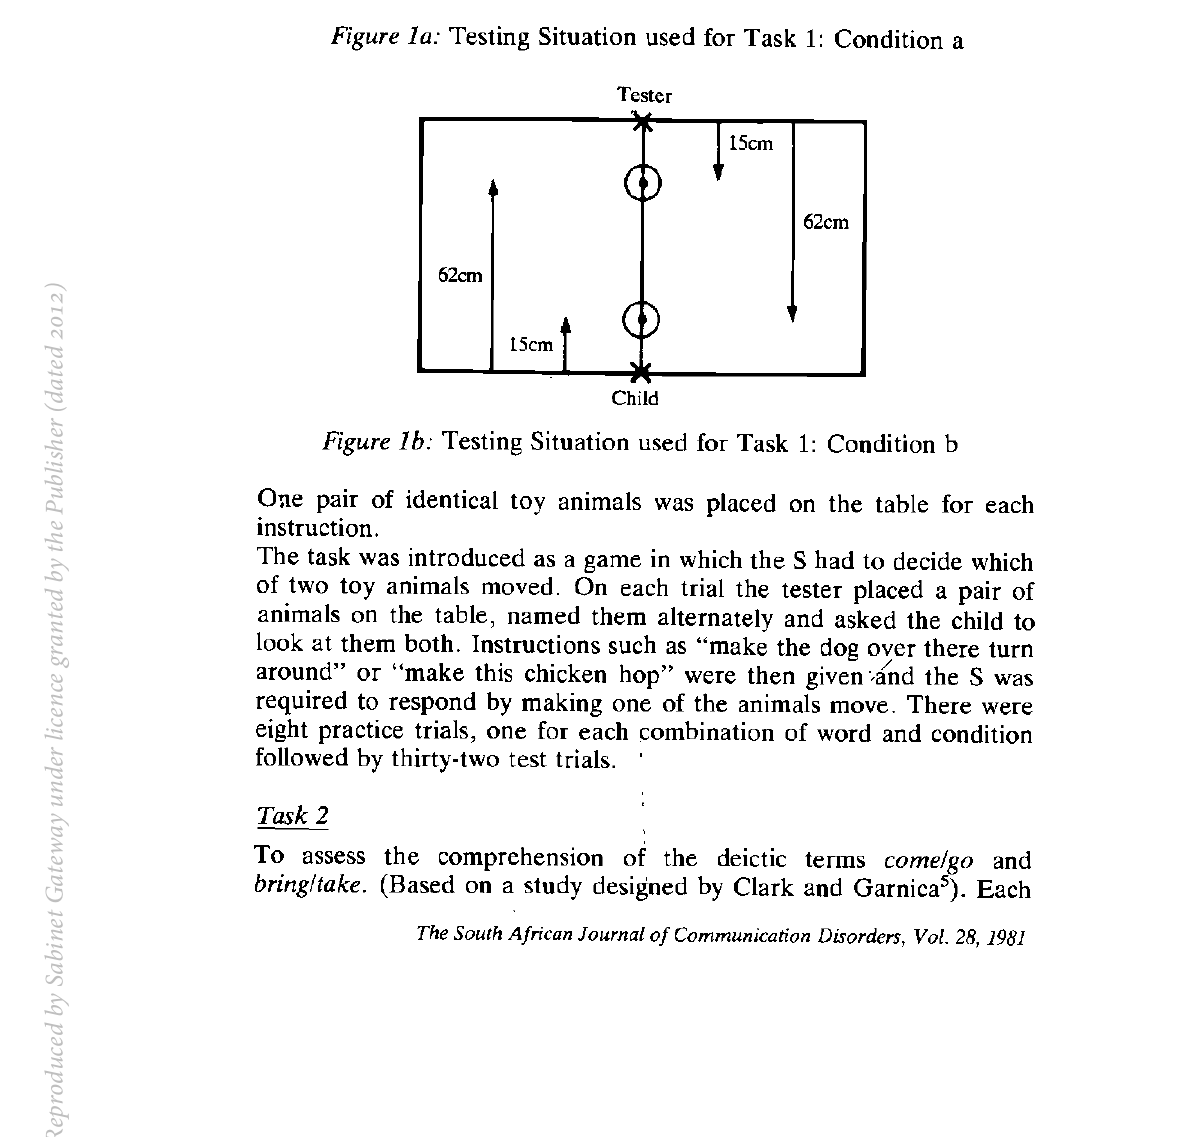
Figure la: Testing Situation used for Task 1: Condition a